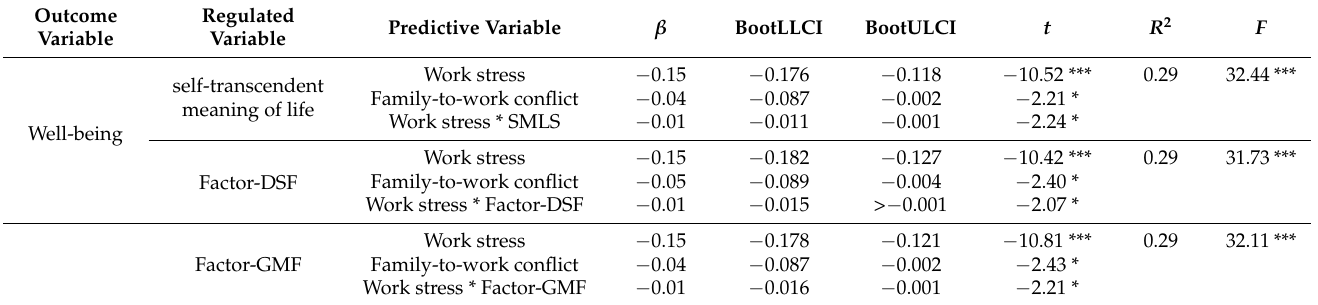
Figure 2. The moderating effect of a self-transcendent meaning of life. Table 3. The moderating effect of self-transcendent meaning of life, factor-DSF, and